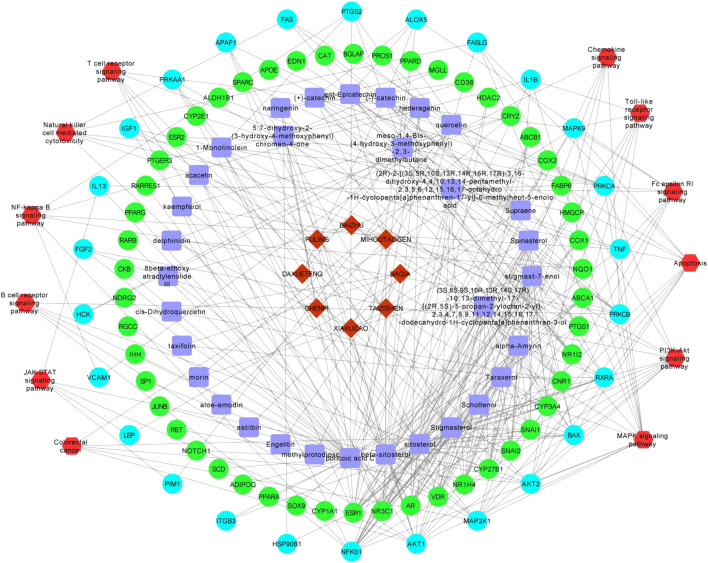
The pharmacological network. Red hombus:herbal medicine; blue square:components; light blue dots: pathway related targets; green dot: non pathway related targets;red hexagon:pathways.